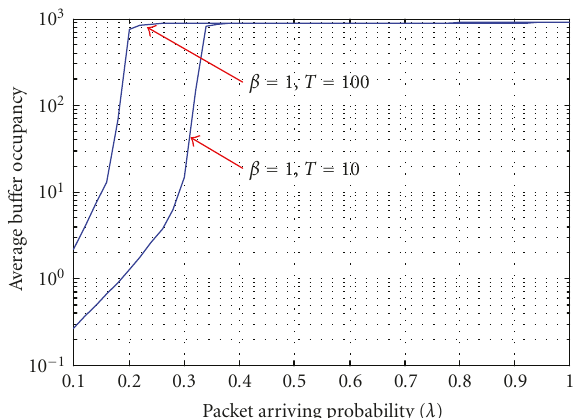
Figure 6: Average bu ff er size versus packet arriving probability ( β = 1 .